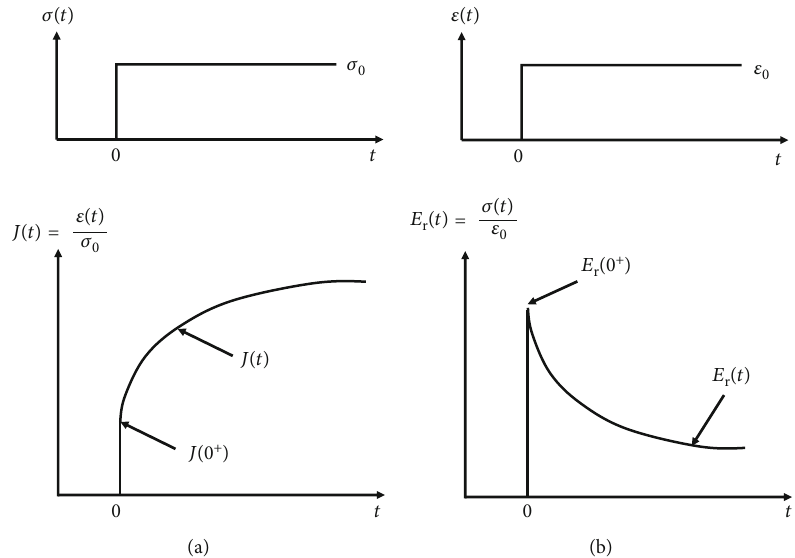
Figure 7: (a) Schematic for creep compliance under a constant stress σ applied, and J ð 0 + Þ is equivalent to the elastic modulus. (b) Schematic for relaxation modulus under a constant strain ε the relaxation modulus at the moment when ε